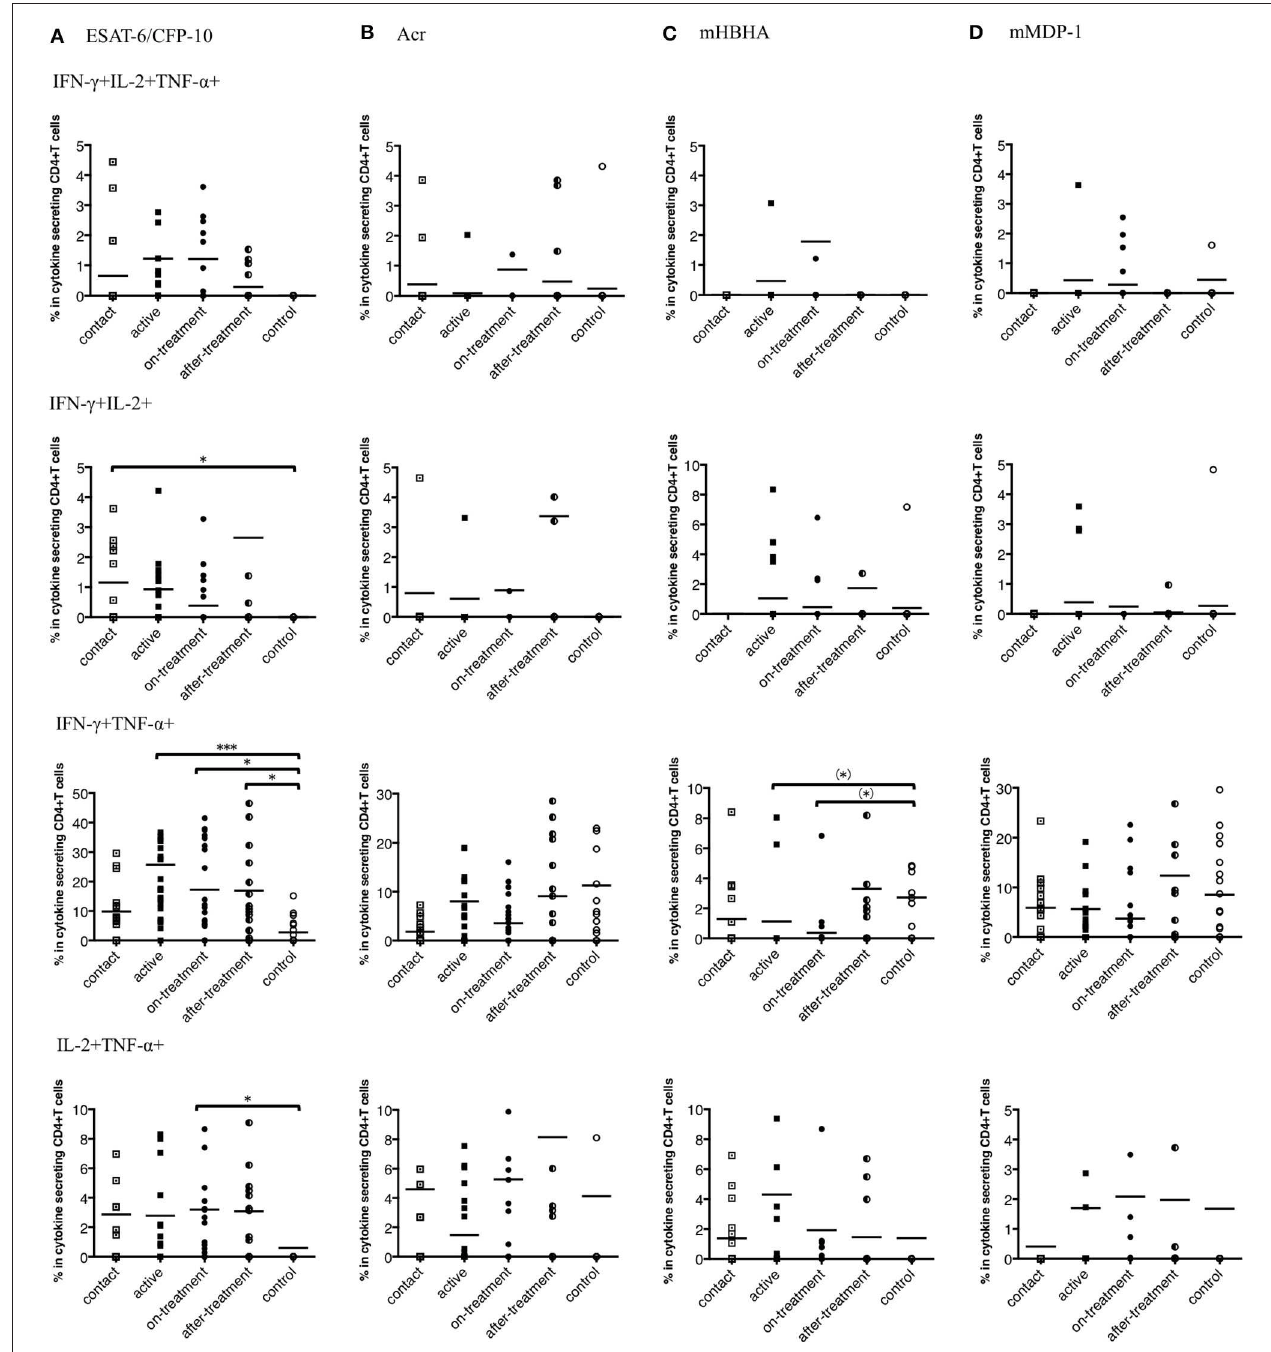
FIGURE 3 | Percentages of polyfunctional CD4 + T cells in IFN- γ , IL-2, and TNF- α secreting CD4 + T cells to M. tuberculosis -associated antigens in M. tuberculosis -infected cases, grouped according to the disease stage as active TB cases ( n = 24), on-treatment TB cases ( n = 24), after-treatment TB cases ( n = 19), and contact cases ( n = 15). Responses of control cases ( n = 18) are also shown. The differences between each set of samples were assessed using the Kruskal-Wallis test and post hoc Dunn’s Comparison test (* P < 0.05, *** P < 0.001). (*) means the possible differences of preselected pairs (* P < 0.05). The long horizontal line represents the mean. (A) Against ESAT-6/CFP-10, three data points are outside the axis in IFN- γ , IL-2, and TNF- α positive CD4 + T cells, five data points are outside the axis in IFN- γ and IL-2 positive CD4 + T cells, five data points are outside the axis in IFN- γ and TNF- α positive CD4 + T cells, and seven data points are outside the axis in IL-2 and TNF- α positive CD4 + T cells. (B) Against Acr, two data points are outside the axis in IFN- γ , IL-2, and TNF- α positive CD4 + T cells, nine data points are outside the axis in IFN- γ and IL-2 positive CD4 + T cells, four data points are outside the axis in IFN- γ and TNF- α positive CD4 + T cells, and 18 data points are outside the axis in IL-2 and TNF- α positive CD4 + T cells. (C) Against methylated (m) HBHA, three data points are outside the axis in IFN- γ , IL-2,